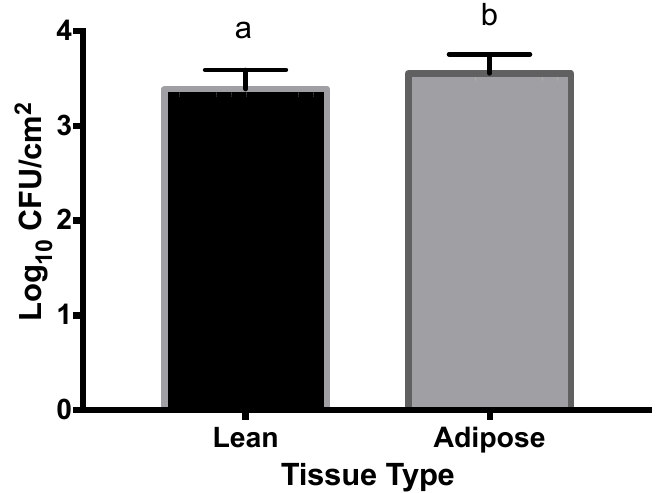
Figure 3. Populations of Shiga toxin-producing Escherichia coli (STEC) cells grown in M9 minimal nutrient media attached to lean and adipose beef brisket tissues. The main effect of tissue type (lean vs. adipose) was significant ( p < 0.0134). As all variable interactions were not significant ( p > 0.05), all data for each tissue type are combined into a single observation. a,b Observations with different superscripts vary